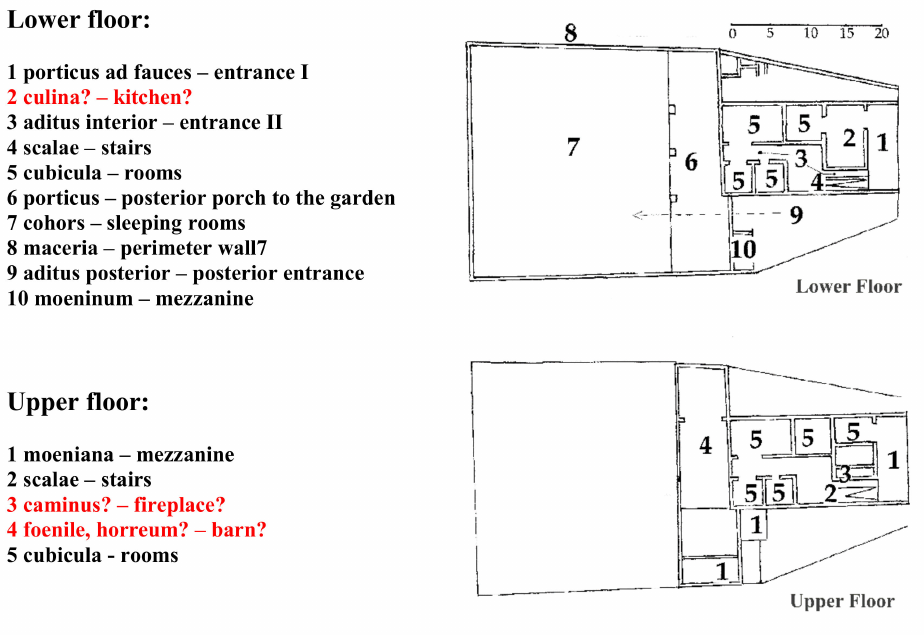
Figure 3. Aedificium custodiae. Distribution of the rooms from [12] (Figure 13, Chapter IV). The figure compares the ground floor and the mezzanine floor of the aedificium custodiae